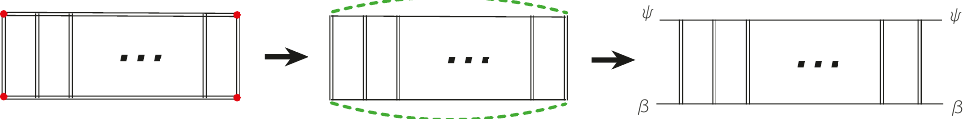
Figure 19 . An example showing how to generate dominant contributions of the quark/squark 4-point functions. We start by inserting four vertices, shown in red, into a mesonic vacuum graph. We then unzip horizontally the two pairs of insertions. Finally we cut the green dashed lines, which come from unzipping the top and the bottom double lines in the previous step, to get the dominant ladder diagrams contributing to the h a ( t 1 ) (cid:12) b ( t 2 ) a ( t 3 ) (cid:12) b ( t 4 ) i 4-point